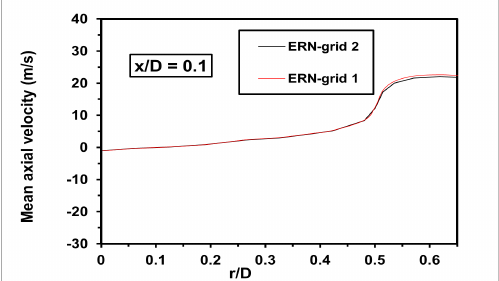
Figure 4. Sensitivity to the mean flow filed grid: The computed mean velocity is compared to the experimental measurements at axial locations x / D = 0.1.